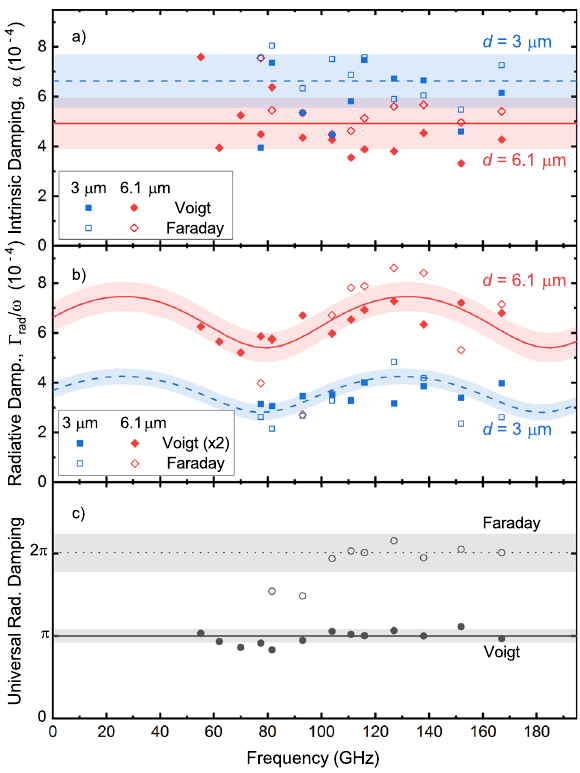
Fig. 4 Frequency dependence of the damping parameters. Dimensionless intrinsic ( α , a ) and radiative damping ( Γ rad / ω , b , c ) parameters are obtained from fi ts of the transmission according to Eq. (7). Damping rates of yttrium-iron-garnet (YIG) samples with different thicknesses ( d ) are indicated by symbol shape (6.1 μ m - red diamond, 3 μ m - blue square), while full/empty fi llings correspond to Voigt/Faraday geometries (magnetic fi eld perpendicular/parallel to light propagation), respectively ( a , b ). Radiative damping of the Voigt experiments in b ) is scaled up by a factor of 2, according to Eq. (9), to allow a numeric comparison with the Faraday-geometry measurements. Mean values of the intrinsic damping parameters belonging to the two samples are indicated by constant lines (6.1 μ m — solid, 3 μ m — dashed line), while standard deviations of the datasets are shown by bands ( a ). Frequency-dependent oscillations of the radiative damping parameters belonging to the two samples are indicated (cid:8) (cid:9) f ð ω Þ by fi ts of Γ rad = ω / 1 (cid:2) n n þ , while root mean squares of the 1 deviations of the data points from the fi ts are shown by bands ( b ). Here ω , n and f ( ω ) stand for the angular frequency, refractive index and the dimensionless correction term due to interference of multiply re fl ected waves inside the substrate. Universal radiative damping rate, (cid:8) (cid:9)(cid:8) (cid:9) n Γ = d γ M (cid:2) n f ð ω Þ , c , agrees with π and 2 π for Voigt (full rad λ n þ 1 1 n þ 1 0 circles, median shown by solid black line) and Faraday (empty circles, median indicated by dotted black line) geometry measurements, respectively. Here λ , γ and M 0 stand for the wavelength, gyromagnetic ratio and the magnetization of the YIG layer. Symbols are obtained by averaging corresponding measurements on the two samples at the given frequency and bands show the standard deviation of the